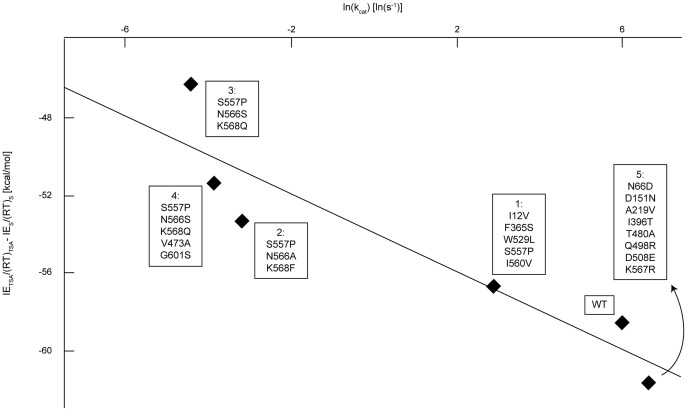
Scaled difference between IETSA and IES for pNP-GLU versus the natural logarithm of kcat.Data was obtained as detailed in the caption of Figure 5. Scaling is required because of the non-quantitative nature of the energy calculations. With scaling, it is apparent that the turnover number increases as the difference becomes more negative. These results suggest that as the enzyme interacts with the TS more strongly, the turnover number increases (R2 = 0.854).